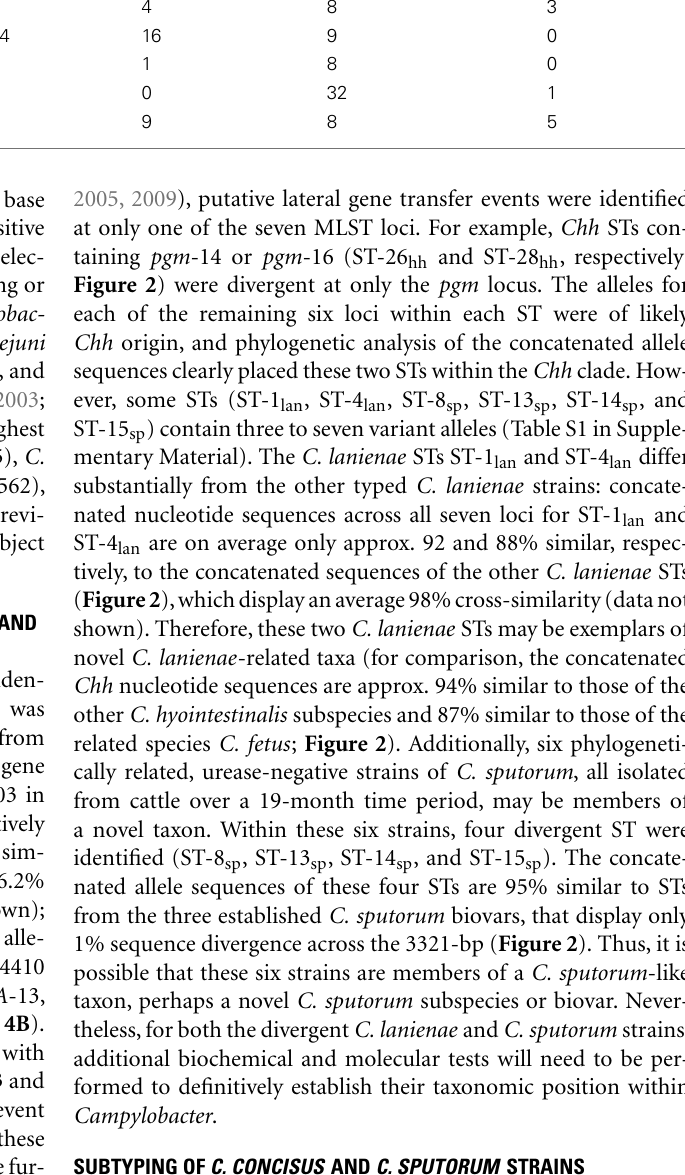
Table 2 | Source of the Campylobacter strains typed in this study. Species